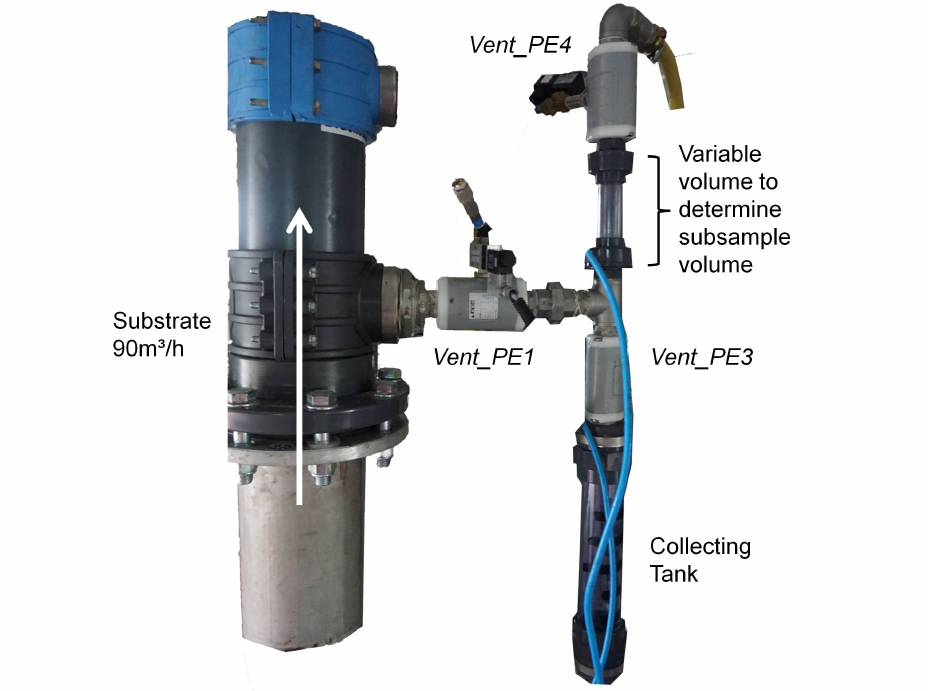
Figure 3. Physical construction of the three valves Vent_PE1 , Vent_PE3 and Vent_PE3 to define subsample volume according to the enclosed air volume, V enclosed